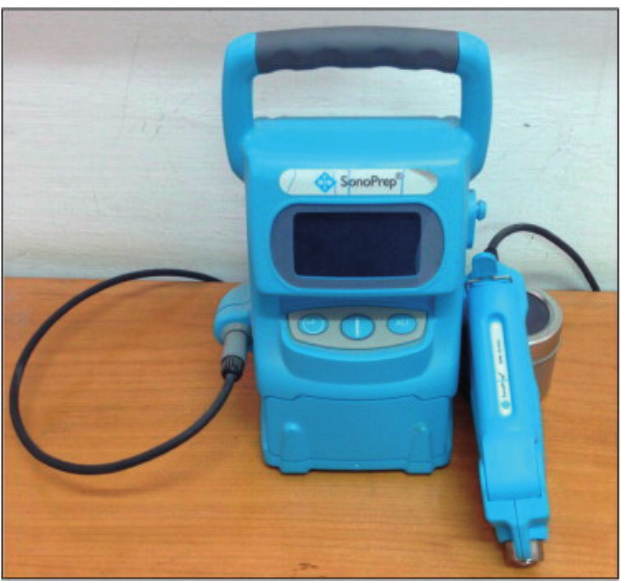
Figure 7. The SonoPrep ® ultrasound device (Reprinted from [50] with permission.